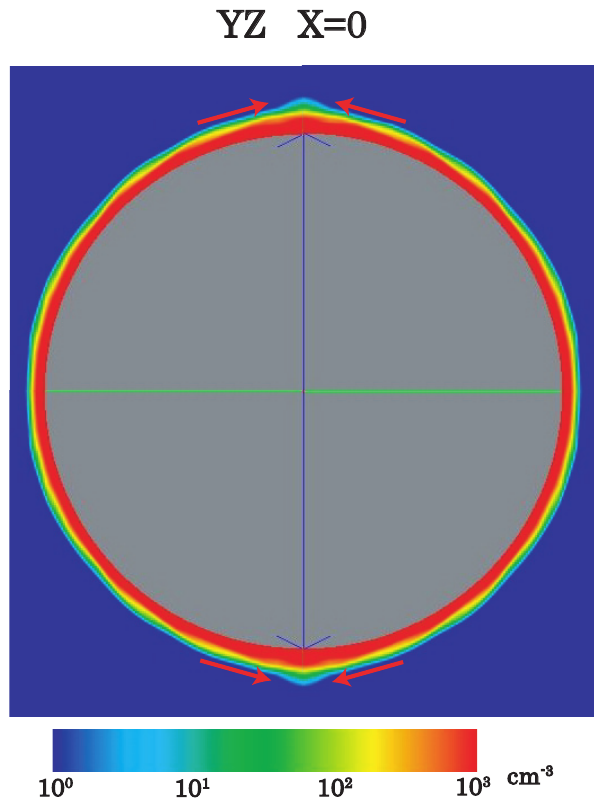
Fig. 8. The O + density pattern on the x = 0 plane. 2